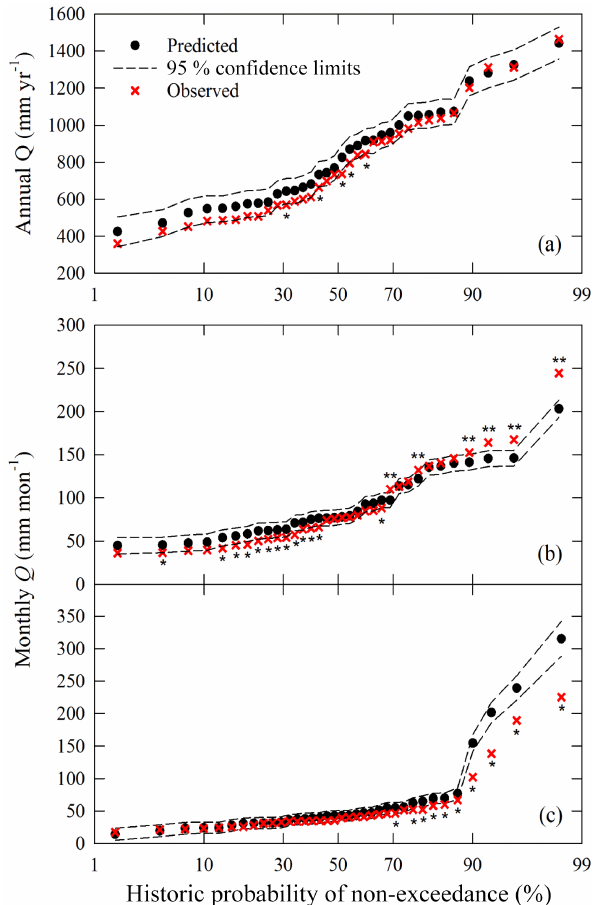
Figure 5. Changes in the cumulative distribution function (CDF) expressed as historic probability of non-exceedance for (a) annual water yield ( Q ), and monthly Q for (b) February and (c) July. ∗ ( p < 0.05) and ∗∗ ( p < 0.01) denote years in the distribution func- tions when Q was significantly lower or higher than predicted.